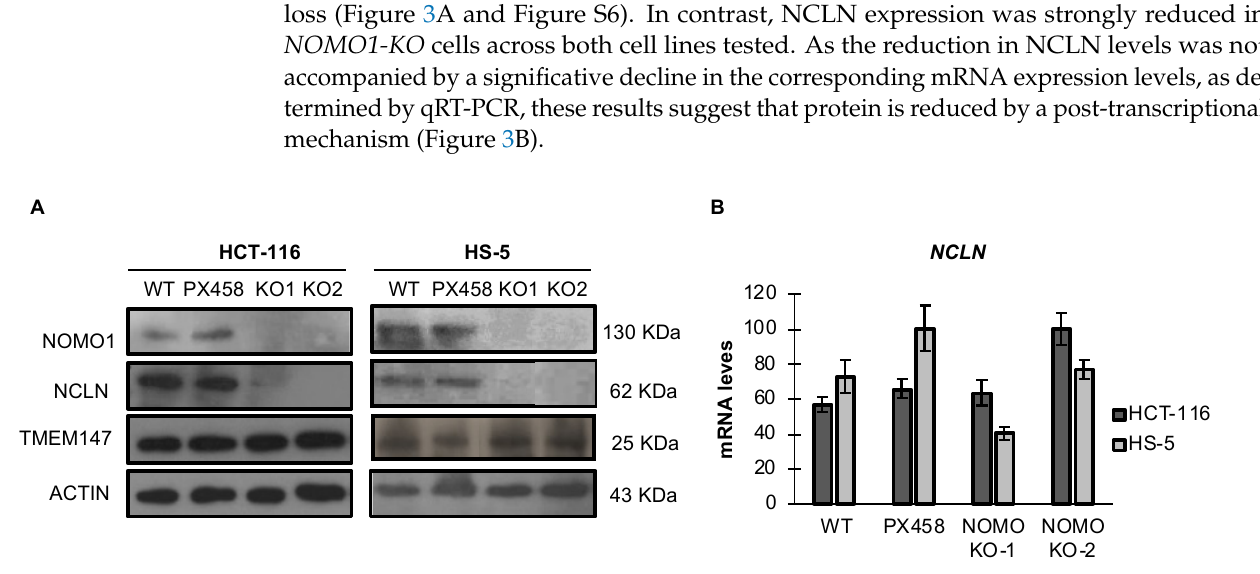
Figure 3. Expression levels of Nicalin and TMEM147 in the presence or absence of NOMO1 across cell lines. ( A ) NOMO1 , NCLN, and TMEM147 protein levels, determined by WB. ( B ) mRNA expression of Nicalin determined by qRT-PCR in NOMO1-KO and control clones. The expression of each clone was determined using the 2 − ∆∆ CT method, and GAPDH was used for normalization. Data are shown as the mean ± SD of three replicates.